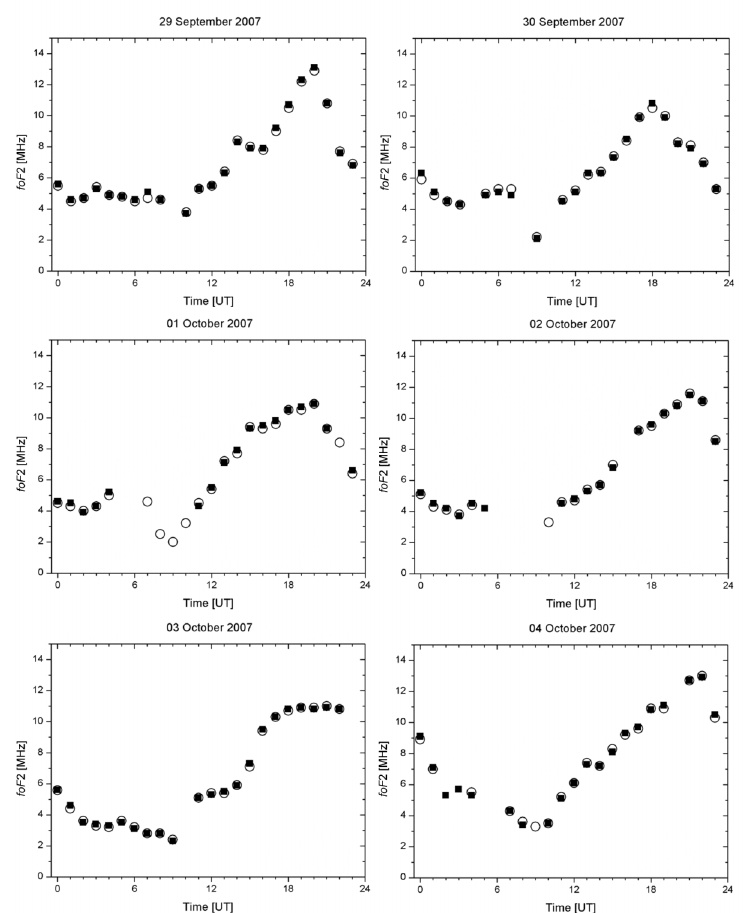
Fig. 7. Hourly foF 2 plots from 29 September 2007 to 04 October 2007 as obtained by the ionograms recorded by the AIS-INGV ionosonde installed at Tucumán. Values manually scaled, and values obtained automatically by Autoscala, are indicated by open circles, and solid squares,